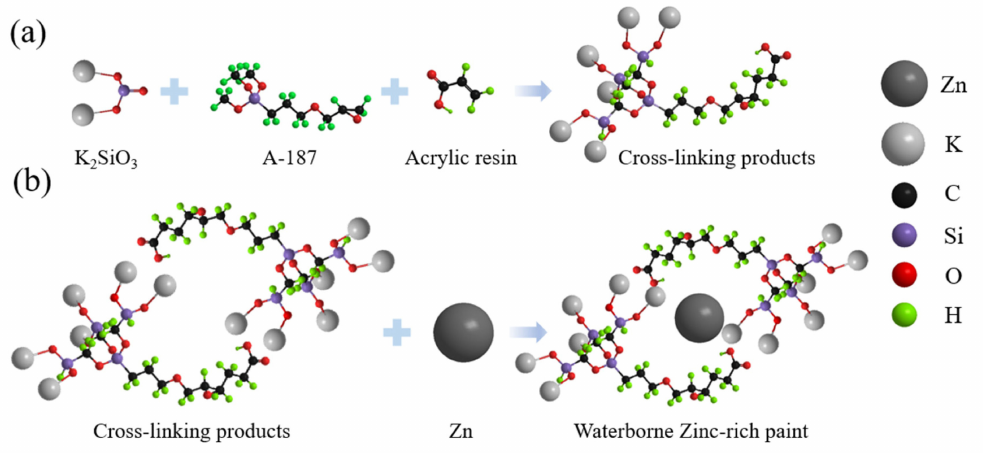
Figure 1. Schematic diagram of the surface modification on a zinc powder: ( a ) Schematic diagram of the silane modification principle ( b ) Schematic diagram of the zinc powder coating